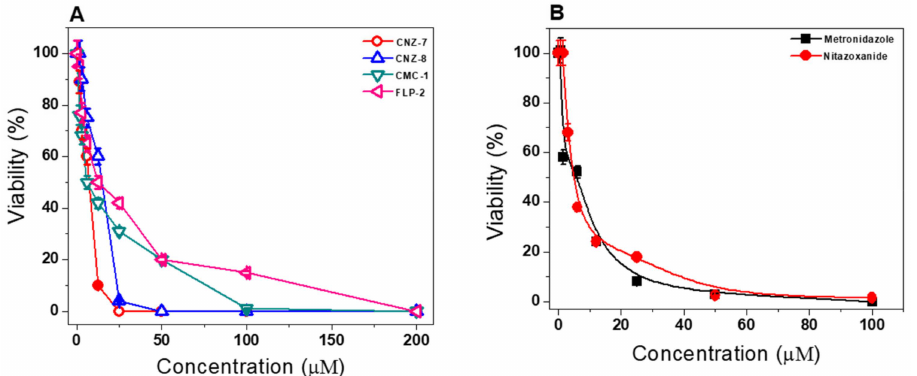
Figure 9. Antigiardial activity of the ( A ) CNZ-7, CNZ-8, CMC-1, and FLP-2 compounds, and ( B ) metronidazole and nitazoxanide on G. lamblia . The trophozoites were incubated in the presence of compounds for 48 h at 37 ◦ C with increasing concentrations of each of the compounds, and later the viability of the trophozoites was determined. The values represent mean ± standard deviation from three independent experiments, and standard errors of the mean were lower than